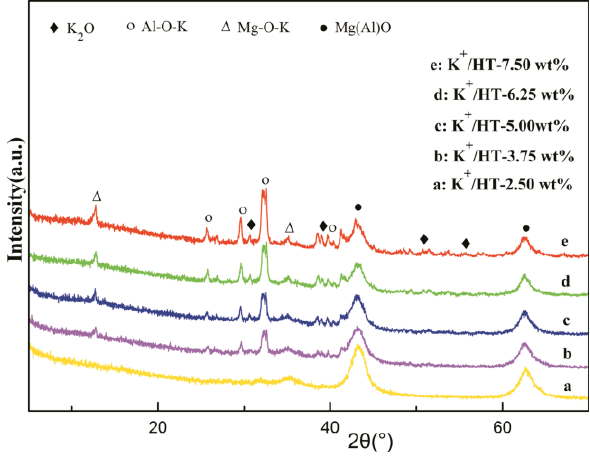
Figure 1. XRD patterns of K + / HT with di ff erent K +